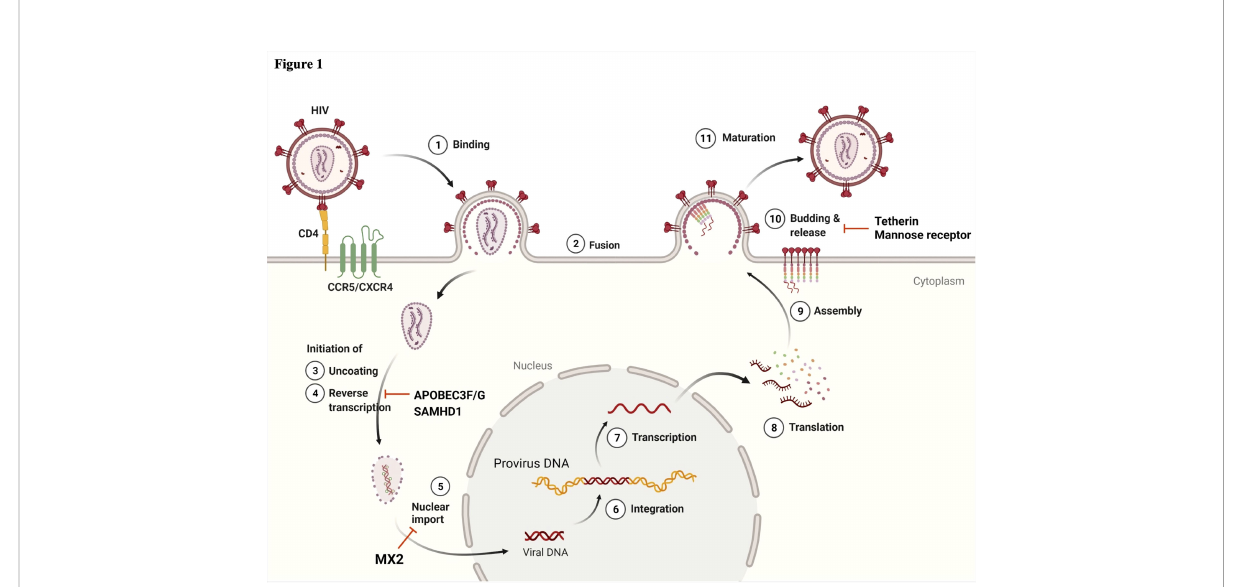
FIGURE 1 Schematic of the HIV-1 life cycle and host factors regulating HIV-1 replication in myeloid lineage cells. ① Viral infection begins by interactions between the viral envelope (Env) and the host cell receptor, CD4, and subsequently with the co-receptors CXCR4 or CCR5. ② This binding enables the fusion of virus to the host cell membrane and the release of viral cores into the cytoplasm. Once the viral core is released, ③ the uncoating and ④ reverse transcription (RT) of viral RNA are initiated in the cytoplasm. Virion-incorporated APOBEC3F/G and target cell SAMHD1 play a role in the inhibition of RT. ⑤ Viral content is transported to the nuclear pore, and uncoating and RT may then be completed. MX2 inhibits nuclear import. Following the completion of RT, ⑥ the viral genome is integrated into the host chromatin DNA. ⑦ Proviral DNA is transcribed and ⑧ translated into the Gag polyprotein. ⑨ Gag polyproteins are assembled at the plasma membrane and ⑩ initiate the viral budding and release of immature virions. Tetherin and mannose receptor (hMRC1) contribute to the inhibition of viral release. ⑪ For viral release from the cell membrane, viral protease cleaves Gag polyproteins, and mature virions are entirely released from the cell membrane. Image created with